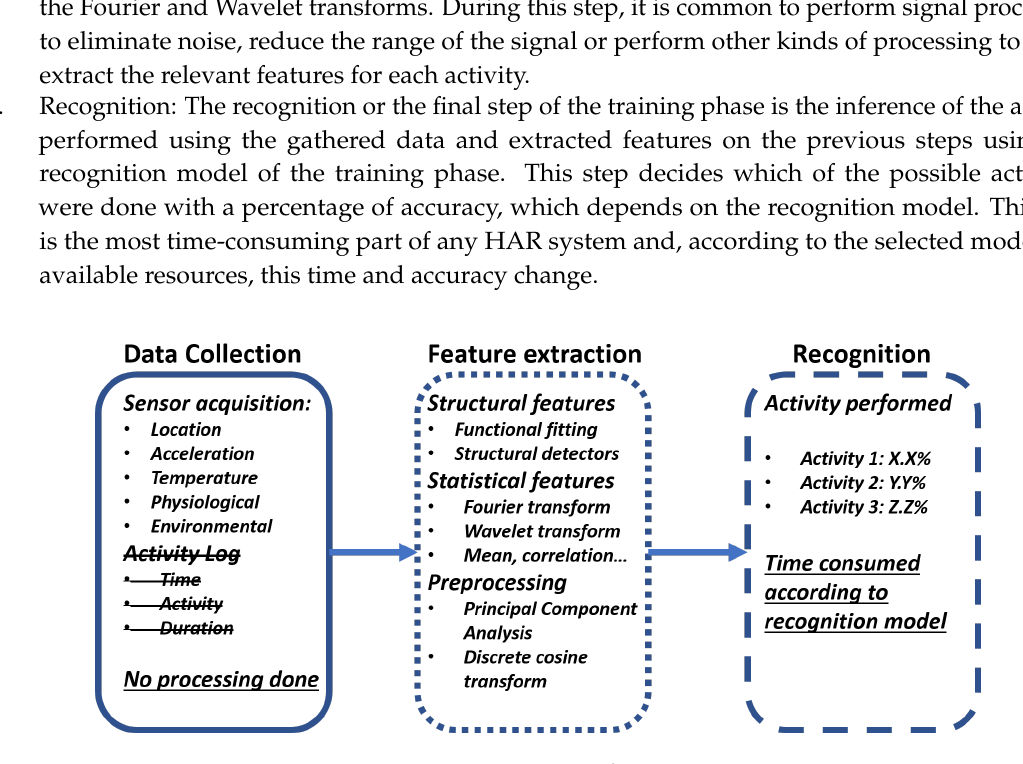
Figure 2. Recognition process of an HAR